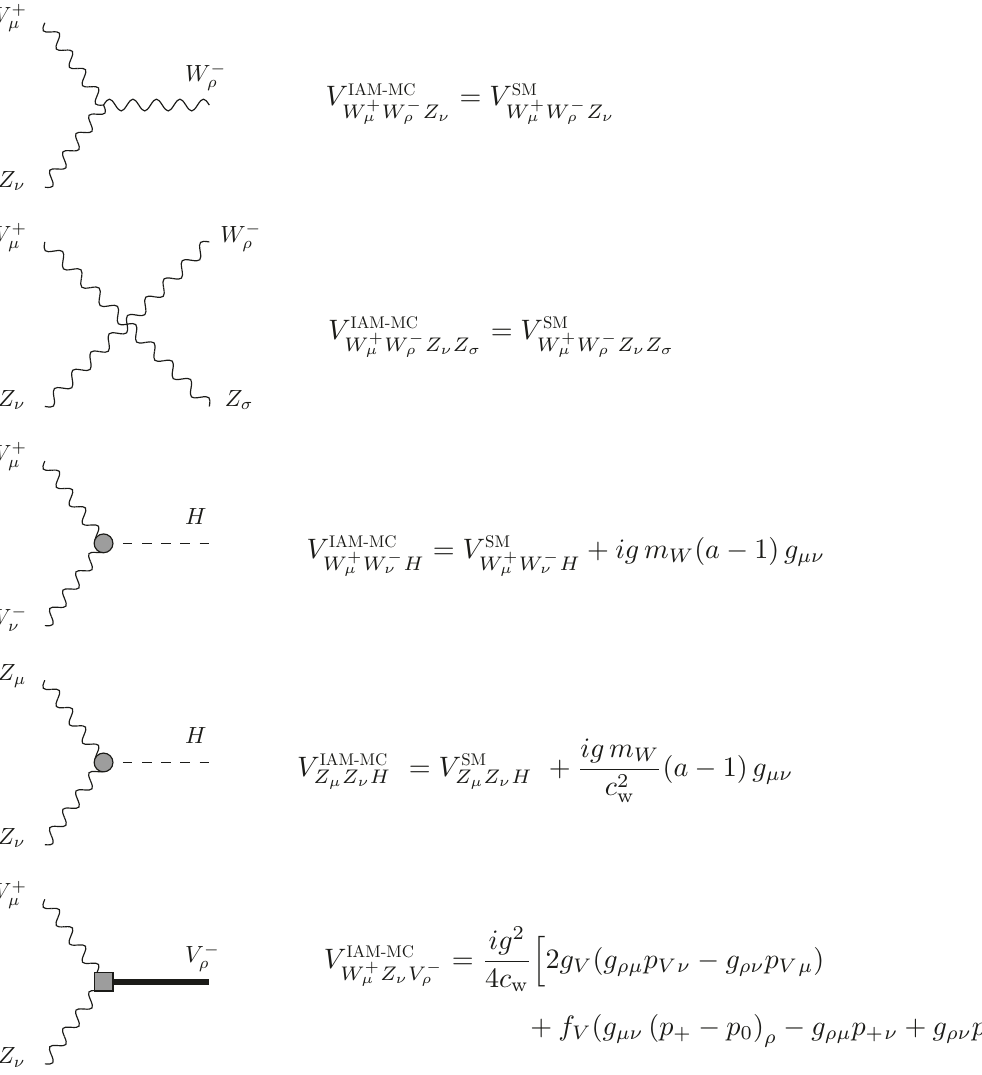
Figure 20 . Relevant Feynman rules for the WZ WZ process in the IAM-MC. Gray circles ! represent vertices that are sensitive to the chiral parameter a . The gray square shows the vertex with contributions from . We take all momenta as L V